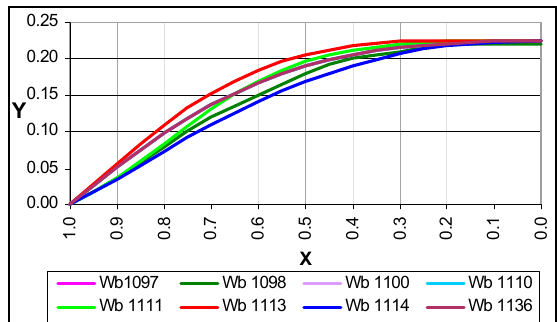
Figure 10. Main waterlines of Weinblum’s models.